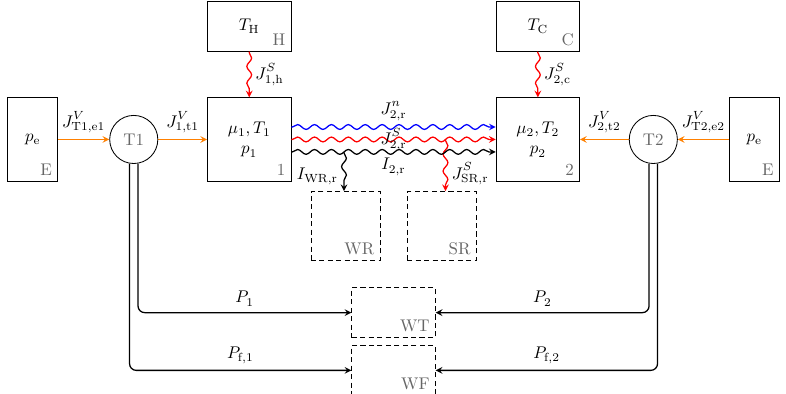
Figure 3. Endoreversible model of the alpha-type Stirling engine with reservoirs (rectangles), engines (circles), and reversible (straight lines) as well as irreversible (wavy lines) interactions. The dashed rectangles represent reservoirs, which are not physically existent but which primarily serve bookkeeping purposes. At the top, there are the hot and the cold heat baths H and C, respectively, which are irreversibly connected to the hot and cold cylinder 1 and 2 of the Stirling engine. The regenerator between these cylinders is modeled as an irreversible interaction. Also, for bookkeeping purposes, this interaction is connected to a work reservoir WR and an entropy reservoir SR. The endoreversible engines T1 and T2 represent the mechanical transmission the pistons are connected to. They further interact with the environment, which is modeled as a (distributed) volume reservoir E. The work reservoirs WT and WF collect the net power and the friction losses, respectively, from the mechanical transmission